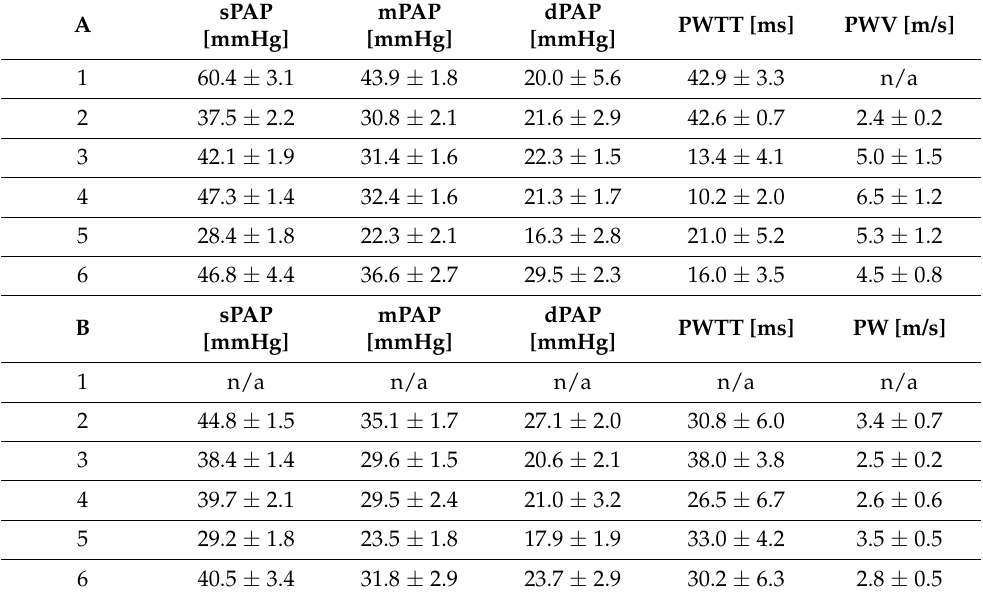
Table 2. Mean values with respective standard deviations for each animal after PH induction either by TXA (A) or by hypoxia (B). Missing data in animal 1 (n/a) are due to unavailable nitrogen gas and missing catheter distance in this